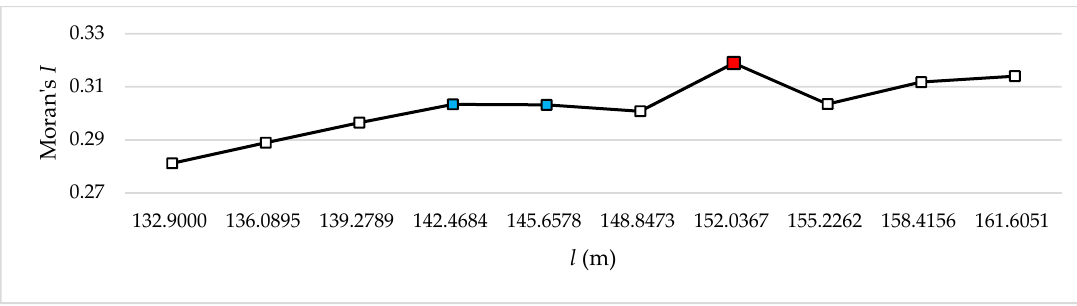
Figure 4. Changes of Moran’s I according to the cluster size at level 9.